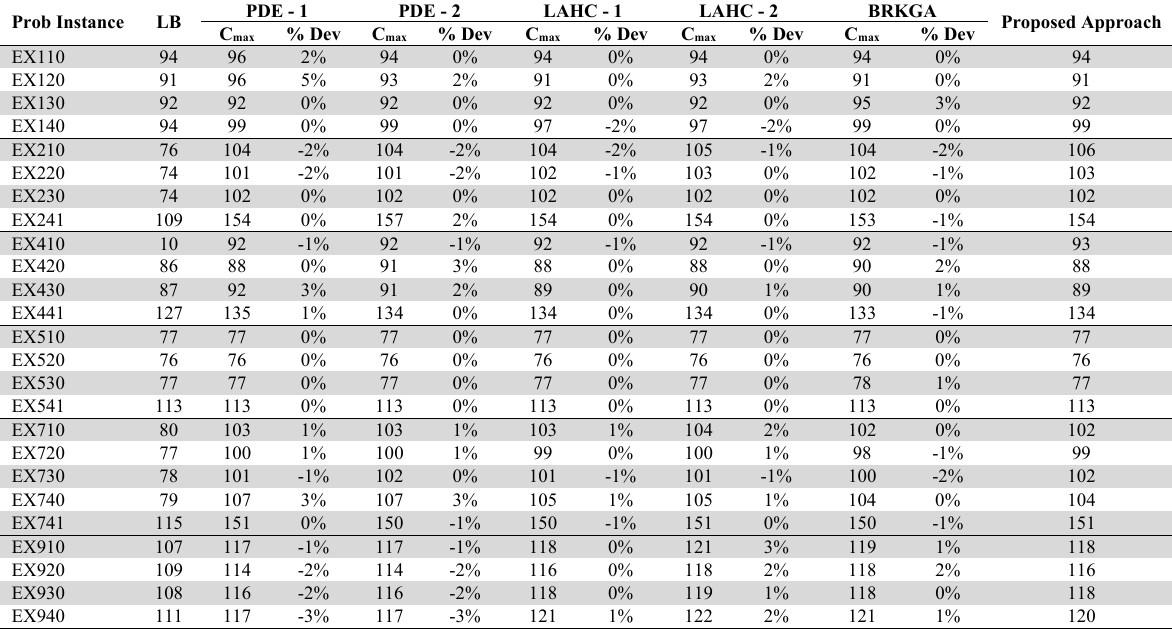
Comparison of Proposed Approach Results for Problem Set 2 for C max minimisation ( t i / p i < 0.25)